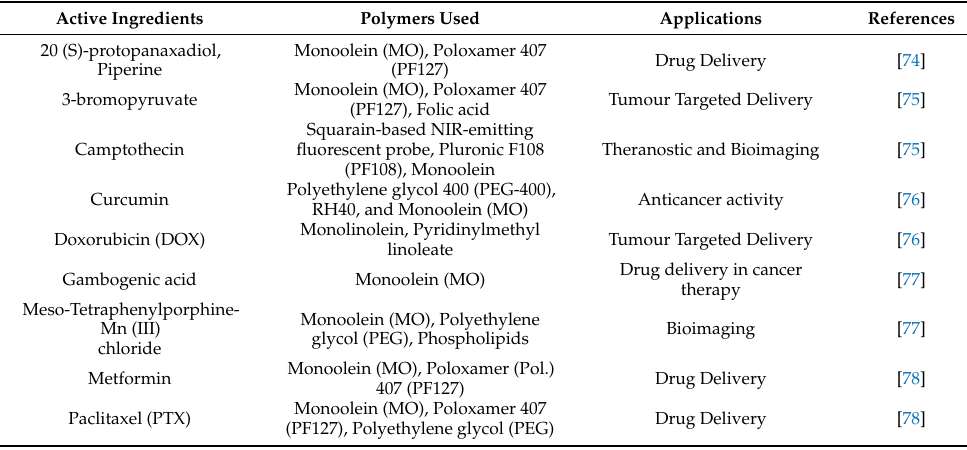
Table 7. List of drugs loaded in cubosomes for anticancer drug